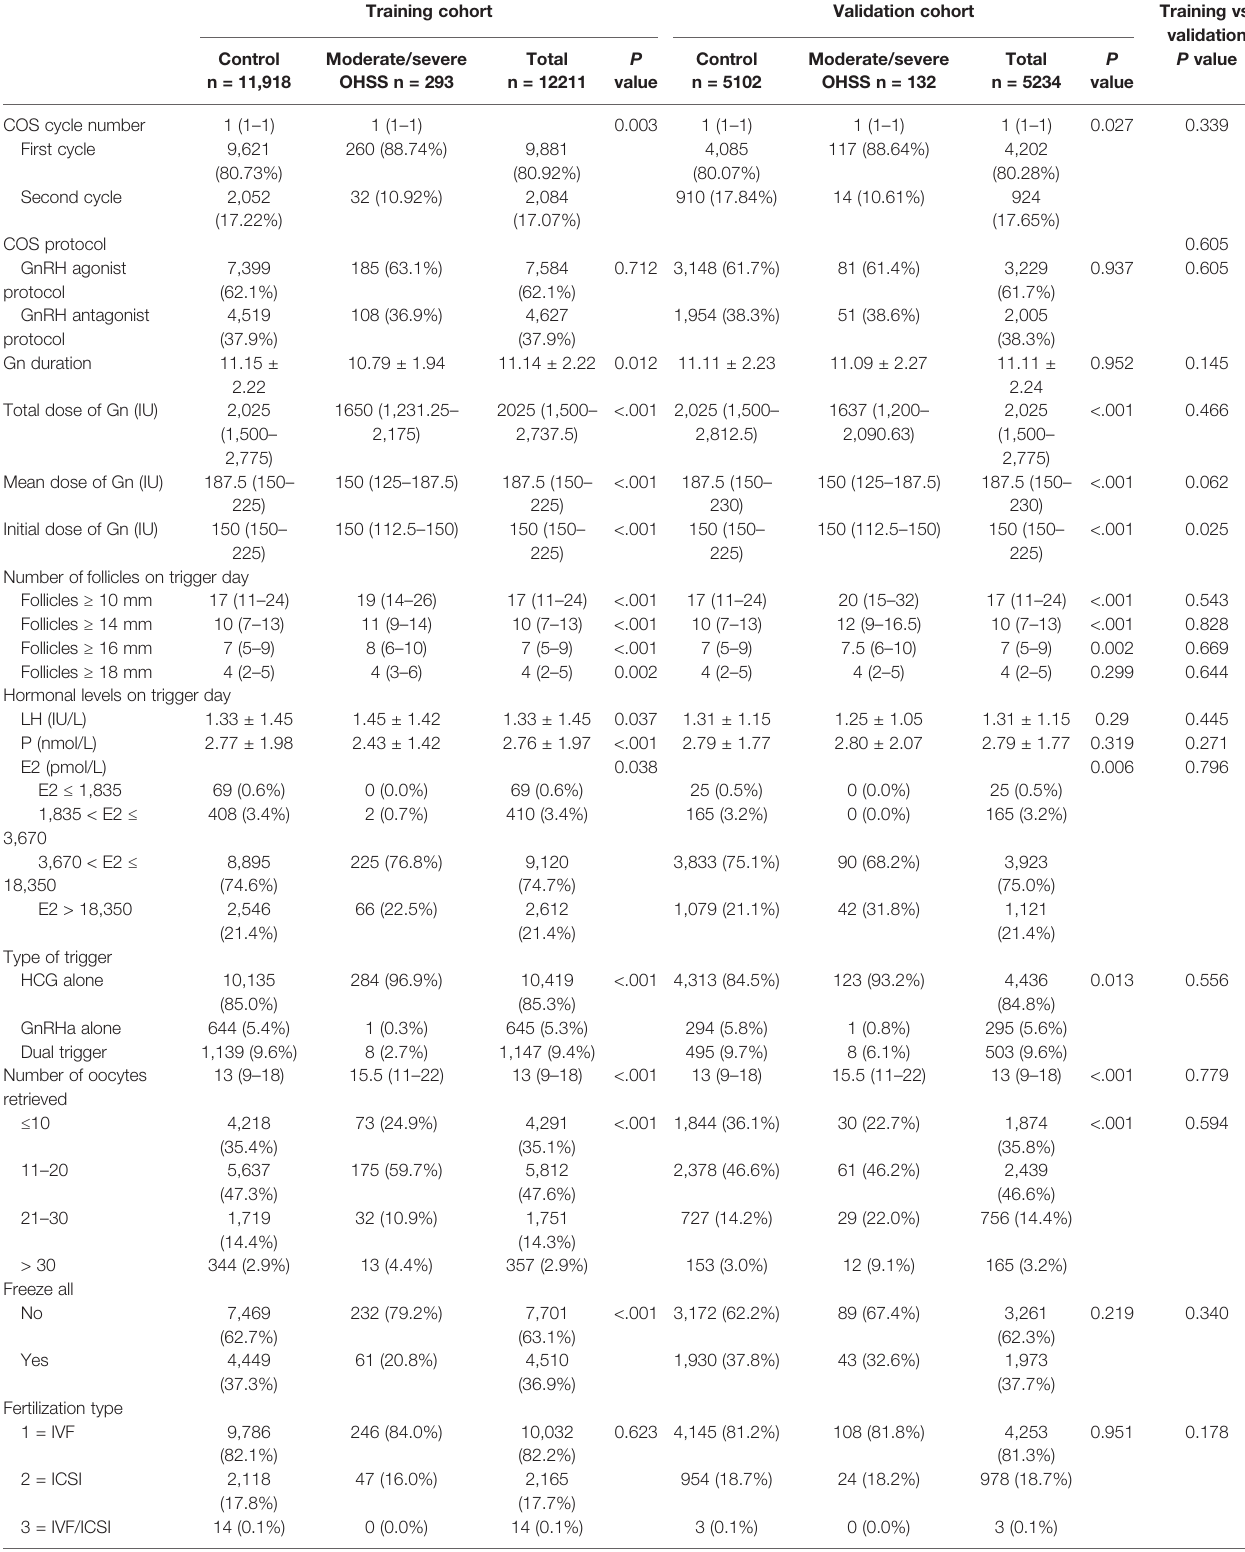
TABLE 2 | Controlled ovarian stimulation cycle related characteristics of the training and validation cohorts. Training cohort Validation cohort Training vs.